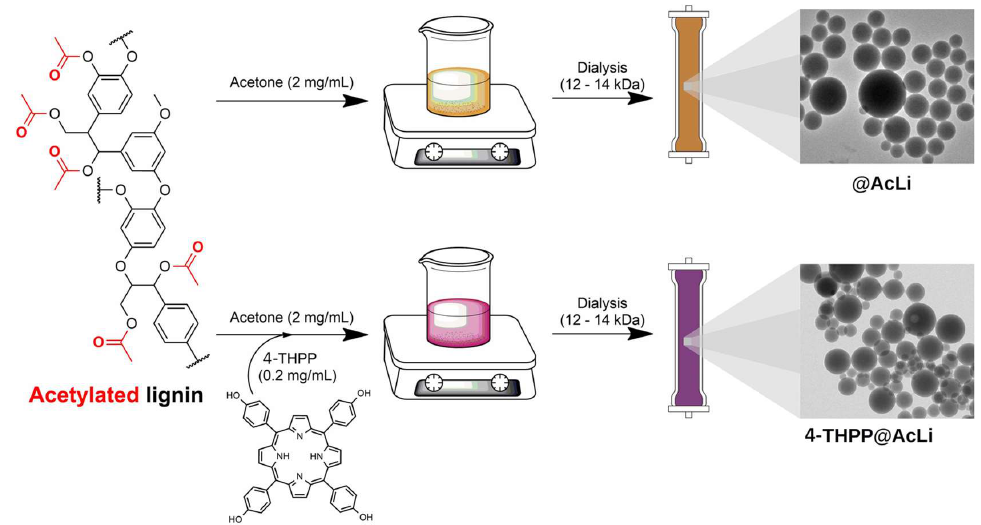
Figure 33. Preparation of acetylated lignin nanoparticles (AcLi) and 5,10,15,20-tetrakis(4-hydroxy- phenyl)porphyrin ( 4-THPP )-loaded on acetylated lignin nanoparticles ( 4-THPP@AcLi ).